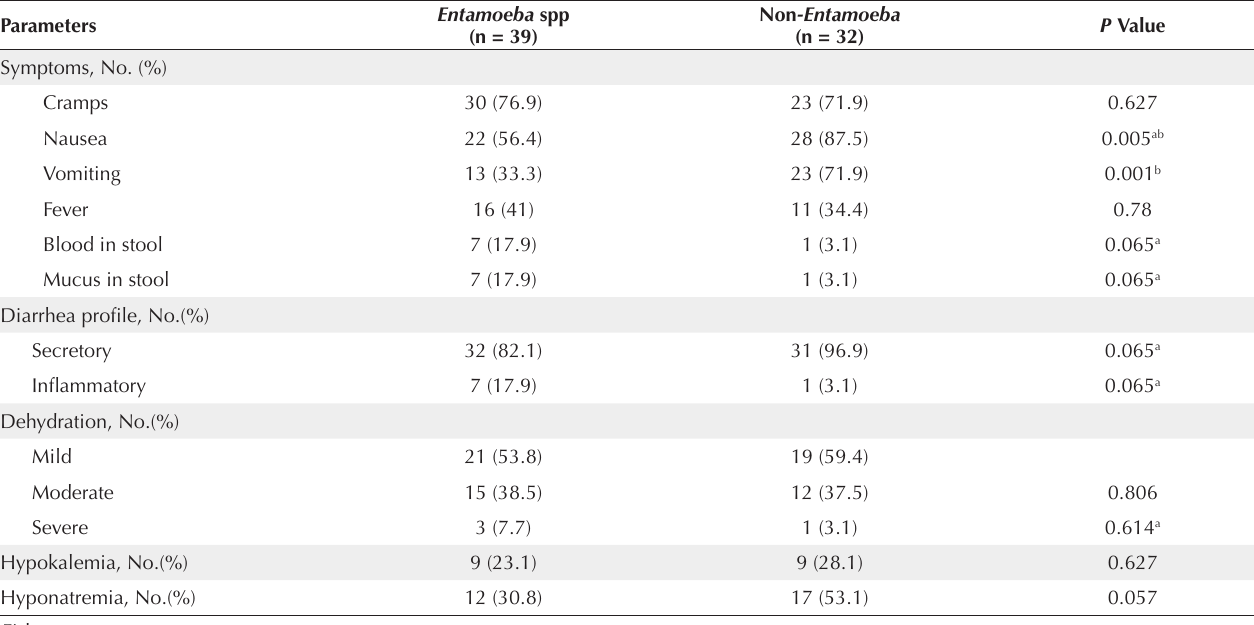
Table 2. Clinical Comparison of Patients With Stools Containing Entamoeba spp. and Patients With Non- Entamoeba spp.